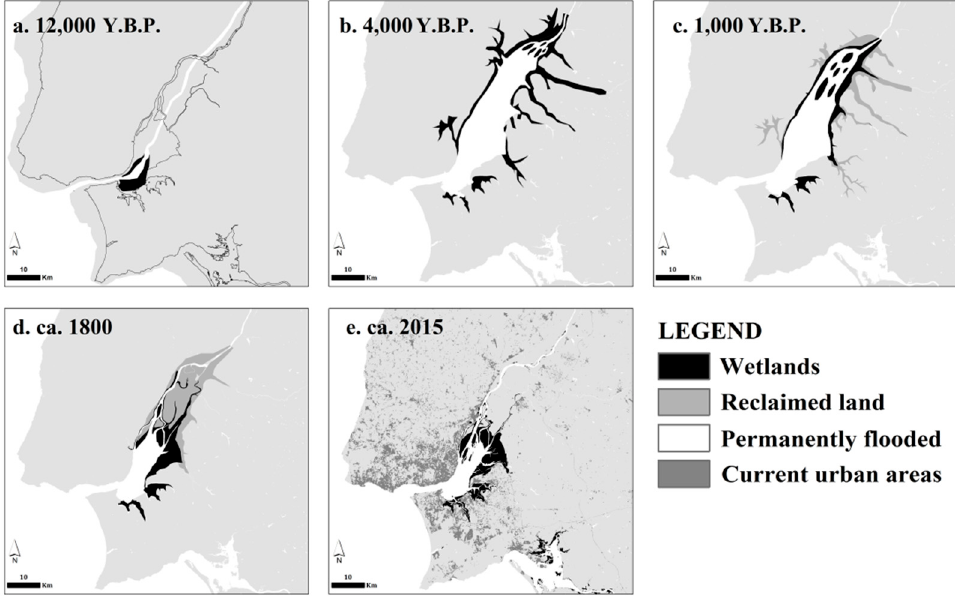
Figure 2. Environmental history of the Tagus Estuary: ( a ) situation of the narrow estuary ~12,000 Years Before Present (Y.B.P.), following the Last Glacial Maximum; after the rate of SLR stabilized, the estuary began to fill and wetlands were finally able to establish more permanently on sheltered portions of the estuary. By ( b ) ~4000 Y.B.P., after a few centuries of expansion, wetlands rimmed narrowly the upstream sections and an expanding delta; ( c ) ~1000 Y.B.P., after at least one millennium of settlement around the estuary and along the basin, increased sediment inflow fed the prograding delta, with reclamation already occurring along tributaries and margins on the upper delta; ( d ) ca. 1800 most of the reclamation of the delta and consolidation of the “lezírias” was complete, but the river still displayed remnants of its former anastomosing delta; ( e ) Current situation. Wetlands are now mostly confined to the widened middle section of the estuary, and the remnant river branches have been transformed into regulated irrigation channels. Urbanization and infrastructure has taken over most of the right bank along Lisbon, Oeiras, and some south bank municipalities. Along the eastern edge of the estuary, the largest expanse of mudflats and marshes is set against farmland, with very limited urban development. The South Bank hosts small but important marshes, heavily encroached by urban development.